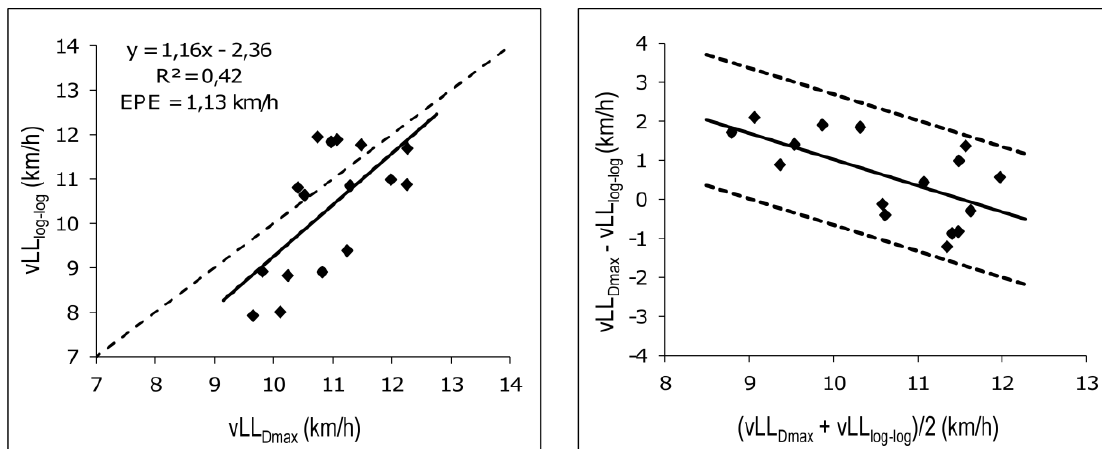
Figura 3. Regressão linear (esquerda) e gráfico de Bland-Altman (direita) entre as velocidades no limiar de lactato determinadas pelos métodos Dmax (vLL 0,65 ( P < 0,01). À direita, o viés (linha contínua) ±1,96 DP (linhas tracejadas) foi de 7,74 – (0,67 × (vLL vLL )/2) ±1,67 km/h ( n = log-log